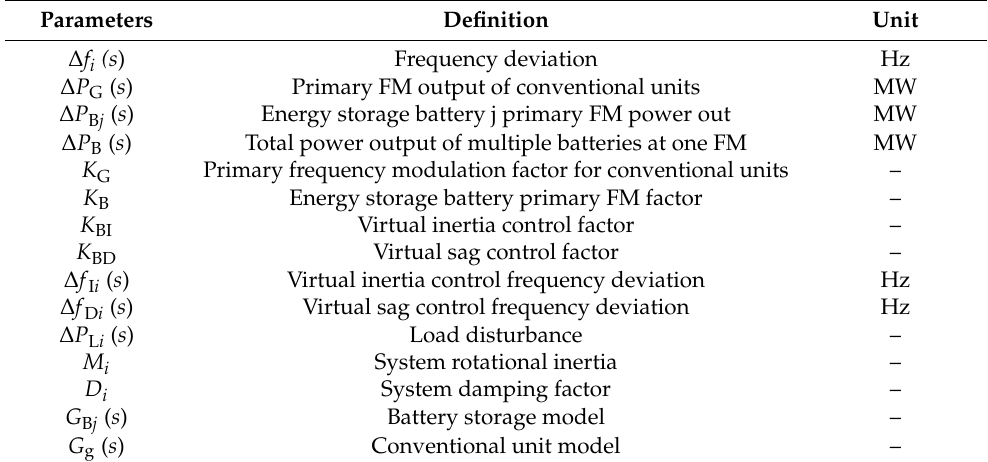
Table 1. Definition of parameters in the